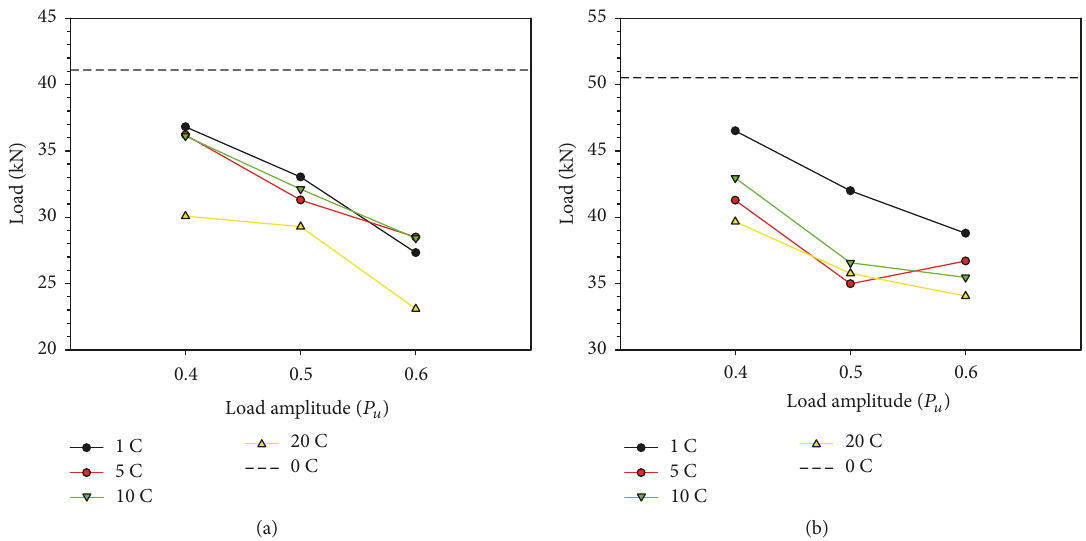
Figure 13: Yield load and ultimate load with load amplitudes and cycle numbers: (a) yield load; (b) ultimate